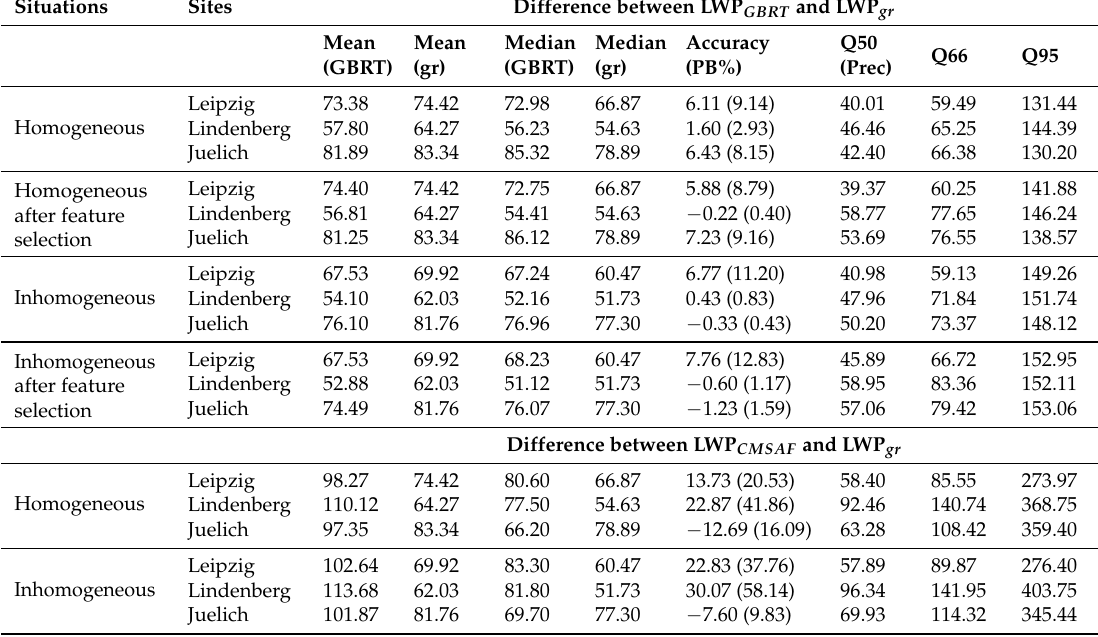
Table A2. Statistics for comparison between LWP GBRT and LWP gr for test data for each site in different situations. Q50, Q66, and Q95 are calculated as the difference between the 25th/17th/2.5th and 75th/83rd/97.5th percentiles of the difference between CloudNet LWP and GBRT-predicted LWP, respectively. Units are g m − 2 for mean, median, Q50, Q66, and